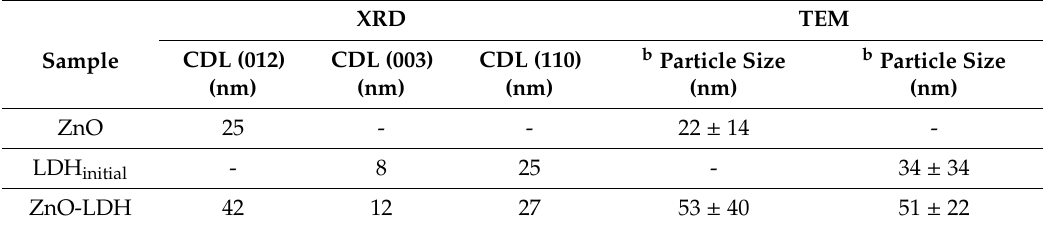
Table 3. Crystal domain length and particle size of ZnO, Mg 2 Al-CO 3 (LDH initial ), and ZnO-LDH